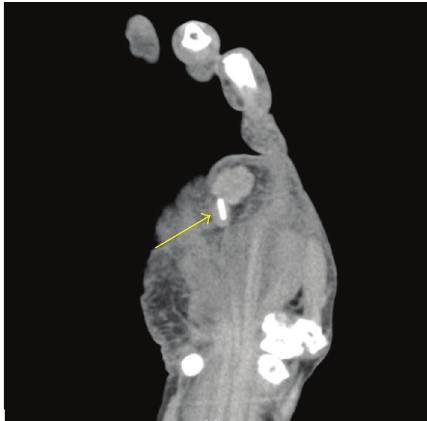
Figure 2: Contrast-enhanced CT showing a linear radiopaque structure of 8mm long with a mass on its distal end.